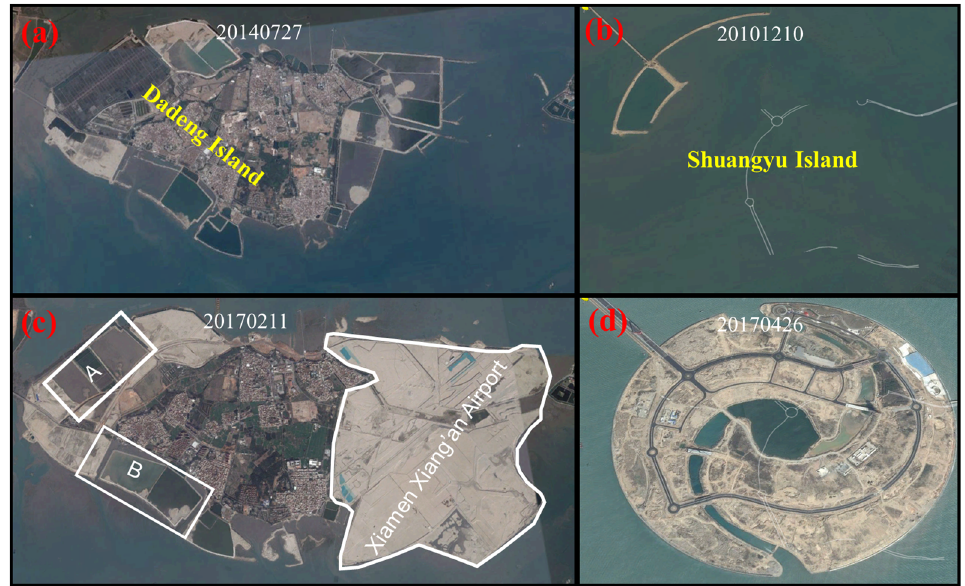
Figure 2. Optical images of the study area. ( a , c ) are images of Dadeng Island acquired on 27 July 2014 and 11 February 2017, respectively. ( b , d ) are images of Shuangyu Island acquired on 20 December 2010 and 26 January 2017, respectively. Two regions A and B in ( c ) will be enlarged and discussed in the discussion section.